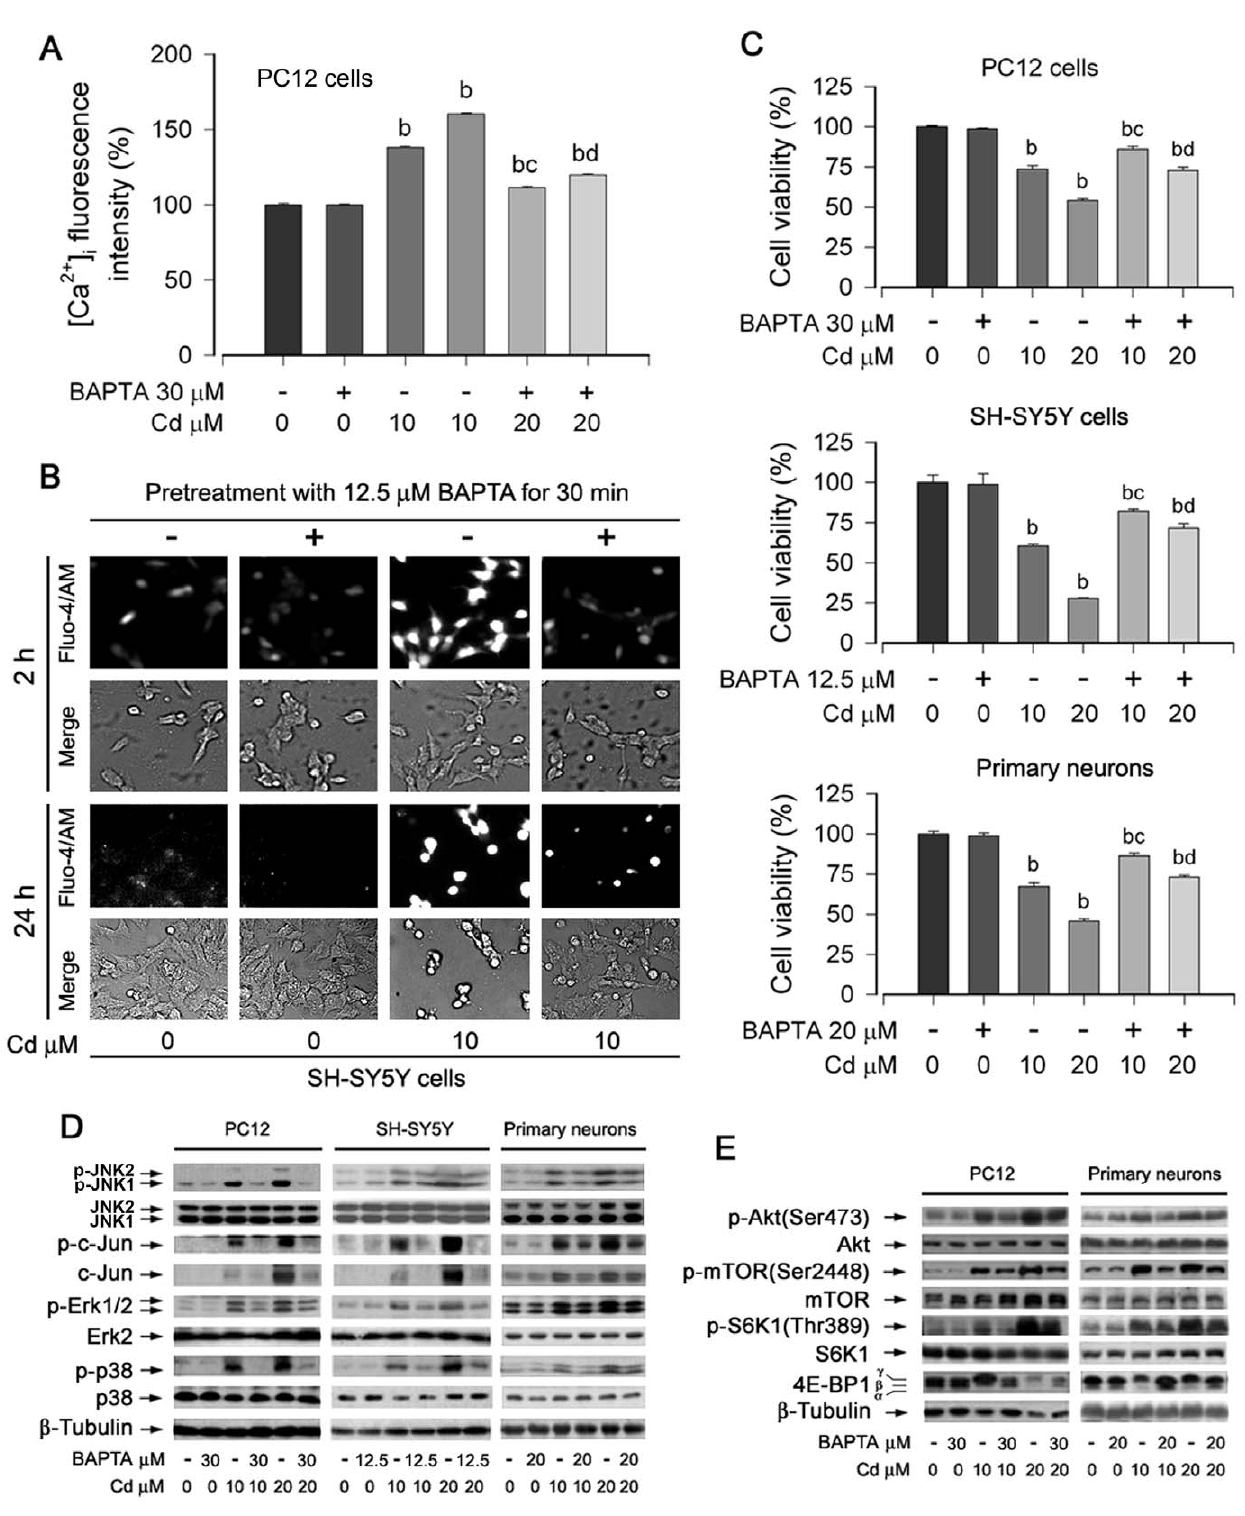
Figure 2. Cd activates MAPK/mTOR pathways and neuronal apoptosis via induction of [Ca 2 + ] i elevation. Indicated cells were pretreated with/without BAPTA/AM at indicated concentrations for 30 min, and then exposed to Cd (10 and/or 20 m M) for 24 h (A–C) or 4 h (D, E). (A) [Ca 2 + ] i in PC12 cells was determined by measuring Fluo-3/AM-labeled fluorescent intensity, as described in Materials and Methods. (B) [Ca 2 + ] i was stained with Fluo-4/AM and visualized by fluorescence microscopy in SH-SY5Y cells. (C) Cell viability for PC12, SH-SY5Y, and primary neurons was evaluated using one solution assay. (D and E) Indicated cell lysates were subjected to Western blotting using indicated antibodies. The blots were probed for b - tubulin as a loading control. Similar results were observed in at least three independent experiments. Results (A and C) are presented as mean 6 SE; n =6. b P , 0.01, difference vs. control group; c P , 0.01, difference vs. 10 m M Cd group; d P , 0.01, difference vs. 20 m M Cd group.